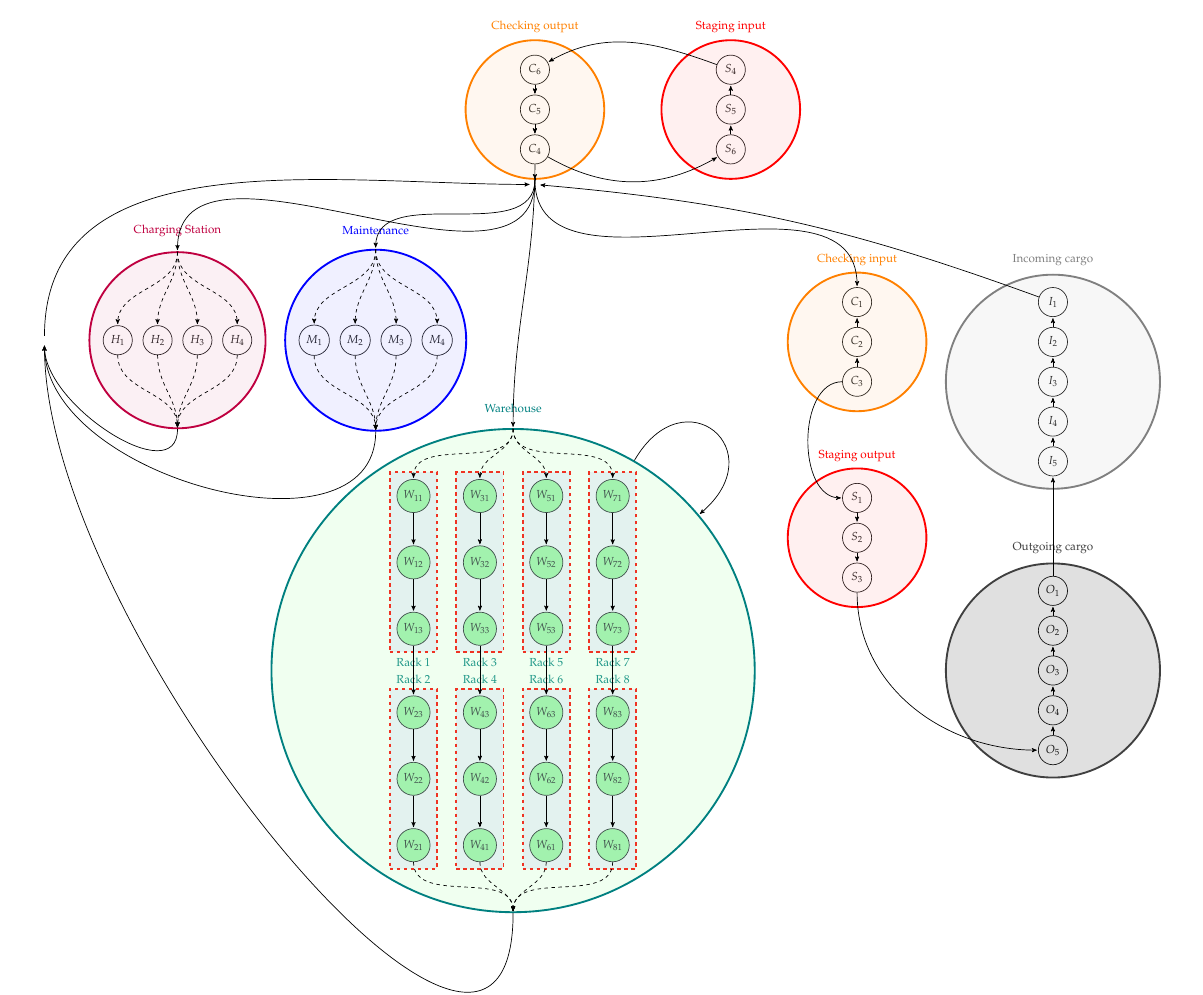
Figure 13. State machine of warehouse logistic process [43] (© 2019